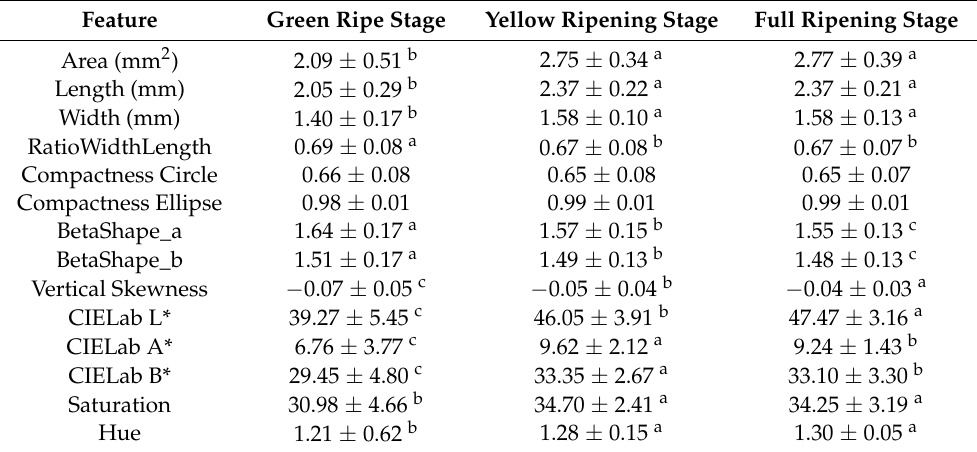
Table 1. Comparative analysis of morphological characteristics of alfalfa seeds with different matu- rity levels.